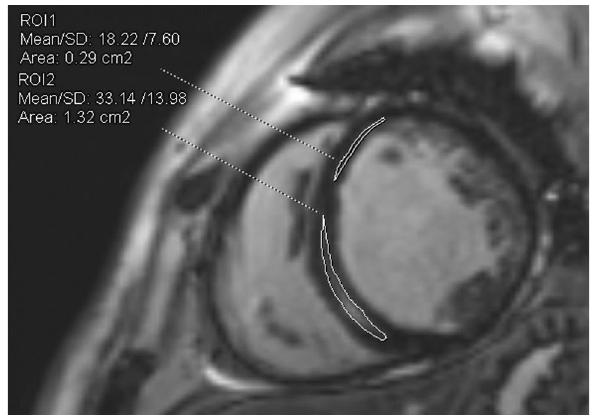
Figure 3. Late gadolinium enhancement (LGE) images demonstrating quantification of the septal burden of replacement fibrosis (encircled) using the 3 standard deviations threshold on consecutive short-axis slices